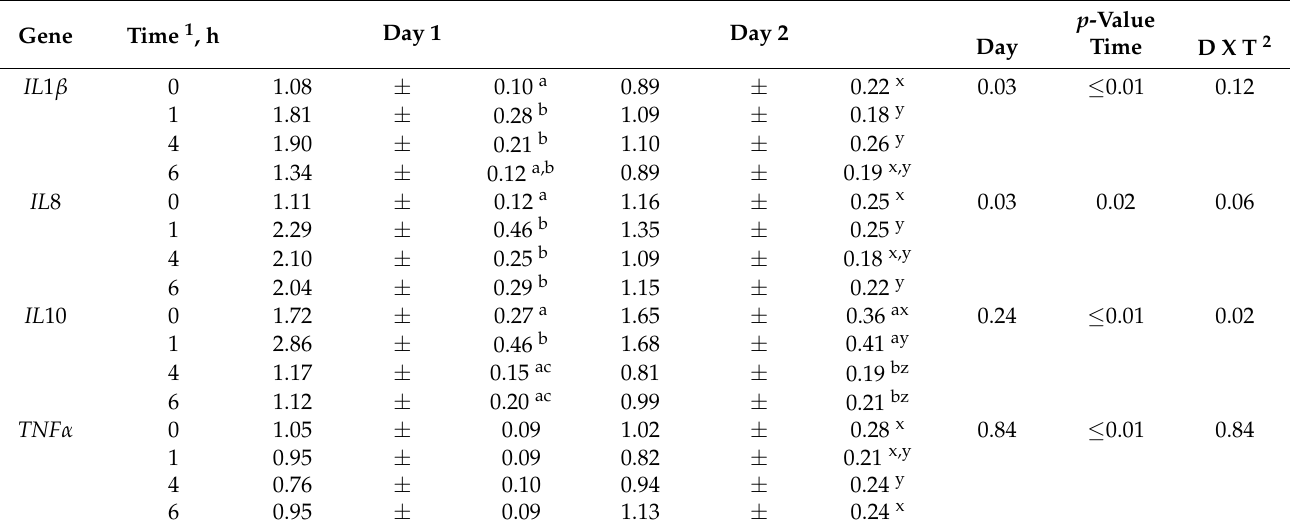
Table 4. Relative expression of cytokine mRNA before (0) and 1, 4 and 6 h